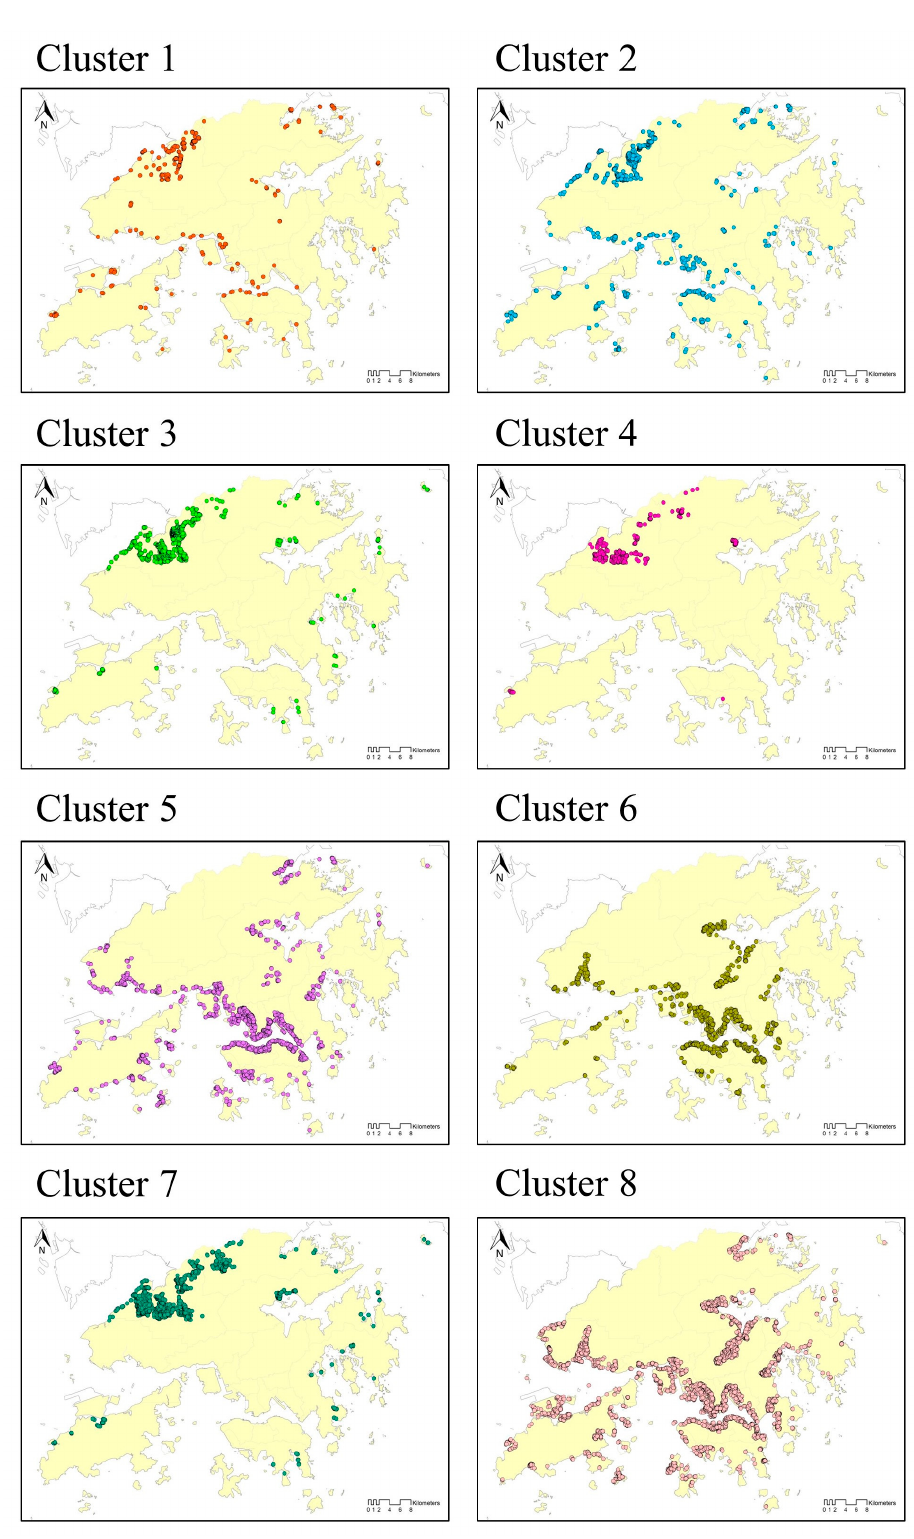
Figure 10. Maps of buildings and their cluster affiliation.